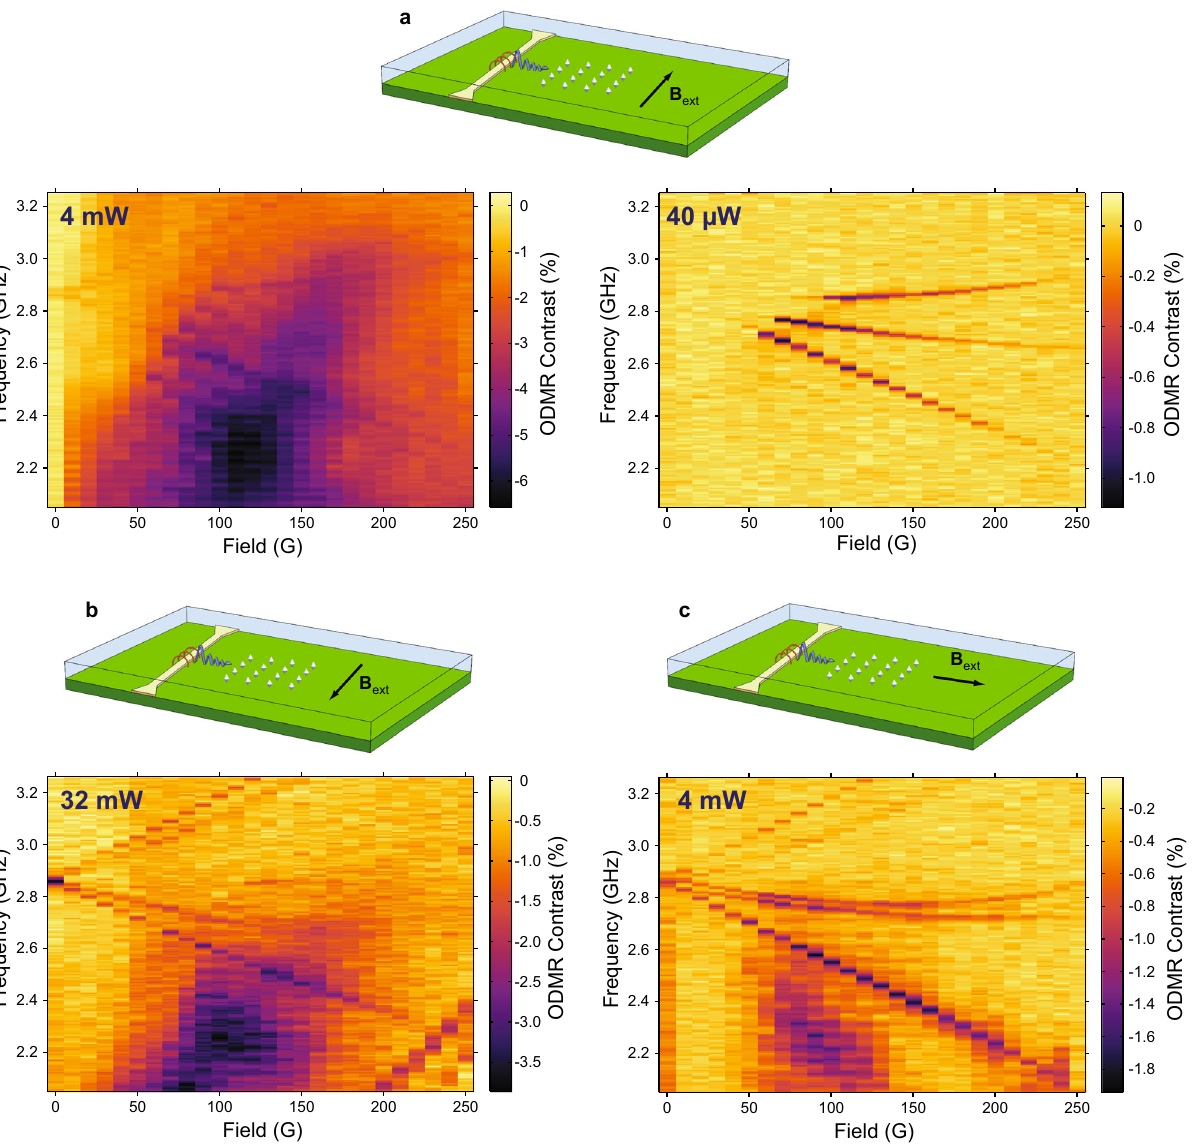
Fig. 2 Dependence of the ODMR spectra on microwave power and external magnetic fi eld orientation. a , Spectra collected in the case of θ = 0. In this condition, we excite DESW modes con fi ned at the surface closest to the NDs. For a microwave power that allows us to resolve the ODMR resonance at zero fi eld ( left ) a strong, broadband PL quenching is visible when the magnetic fi eld is increased. By decreasing the microwave power by two orders of magnitude ( right ) we enter a regime where the non-resonant PL quenching is suppressed and discrete NV center resonances are visible at fi elds above 60 G. b , Spectra collected for θ = π using 32 mW of microwave power. In this condition, DESW are still excited, but the SW is now con fi ned at the opposite surface of the YIG layer, resulting in the strong reduction in the PL quenching effect. c , Spectra collected for θ = π /2 using 4 mW of microwave power. Here, we drive SW modes with sinusoidal pro fi les across the YIG layer. The absence of a strong surface con fi nement in the proximity of the NV centers results again in strongly diminished effects on the